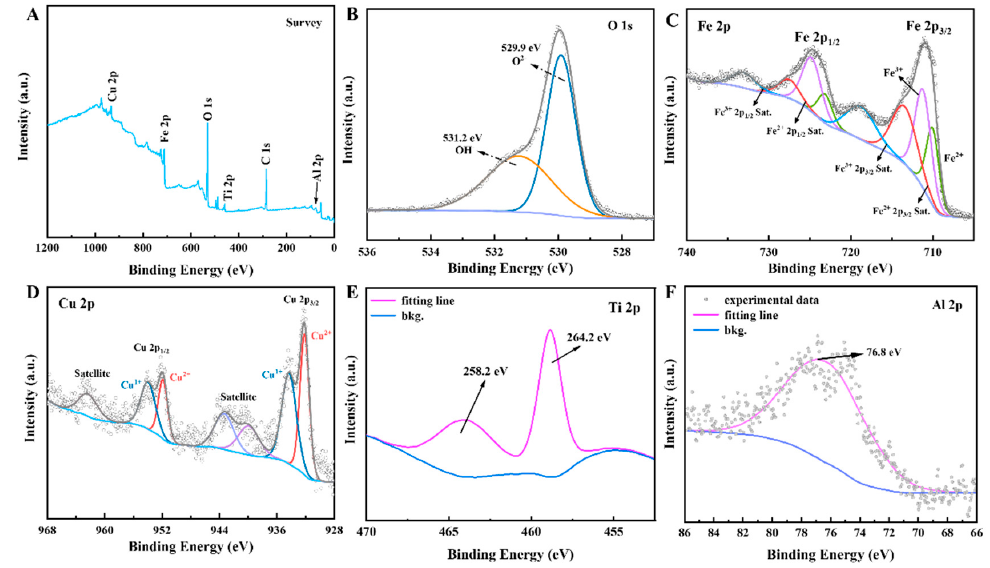
Figure 3. XPS spectra of Ti:Fe 2 O 3 /Cu 2 O: ( A ) Survey, ( B ) O 1s, ( C ) Fe 2p, ( D ) Cu 2p, ( E ) Ti 2p, and ( F ) Al 2p.